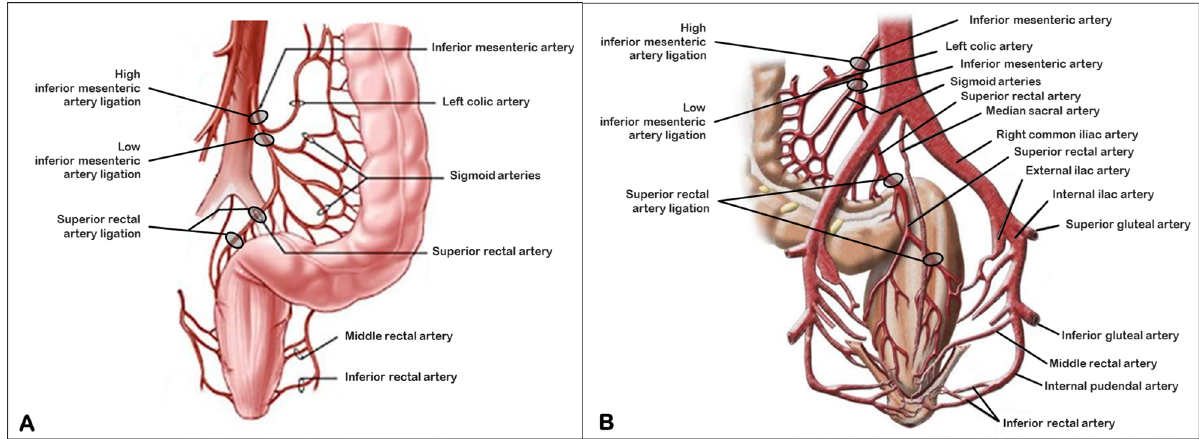
Figure 1. HYPERLINK "sps:id::fig1||locator::gr1||MediaObject::0" The IMA originates from the front of the abdominal aorta at the level of L3 vertebra, about 3–4 cm above the bifurcation of the abdominal aorta. Sites of artery ligations are reported in figure A and B in front and back view,